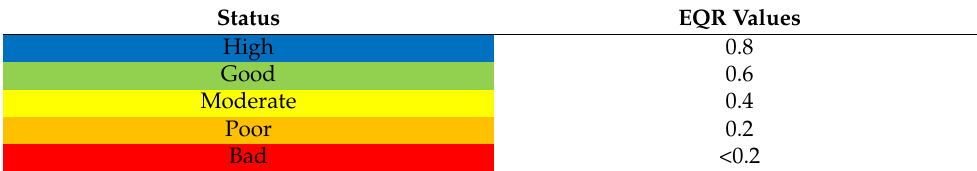
Table 3. Biological Status Boundary Values